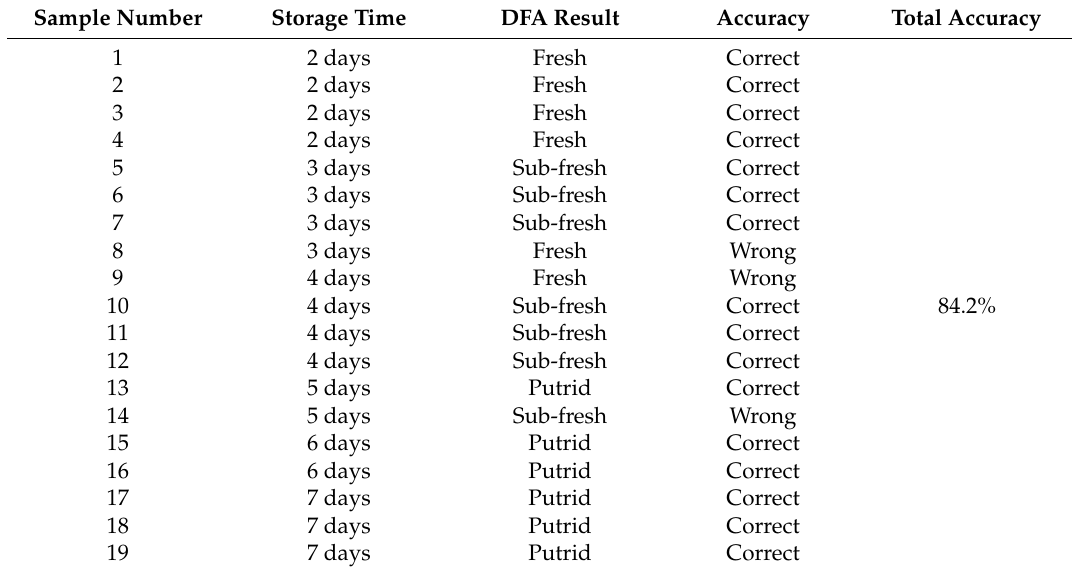
Table 4. DFA results of 19 unknown beef